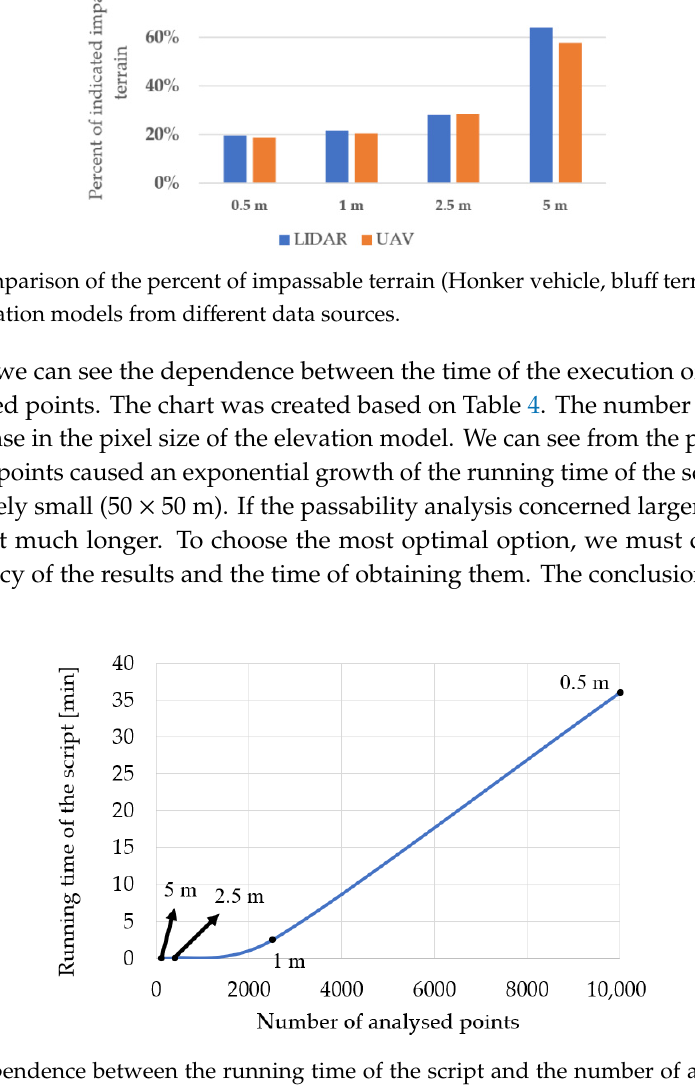
Figure 21. Dependence between the running time of the script and the number of analyzed points (pixel size near dots).